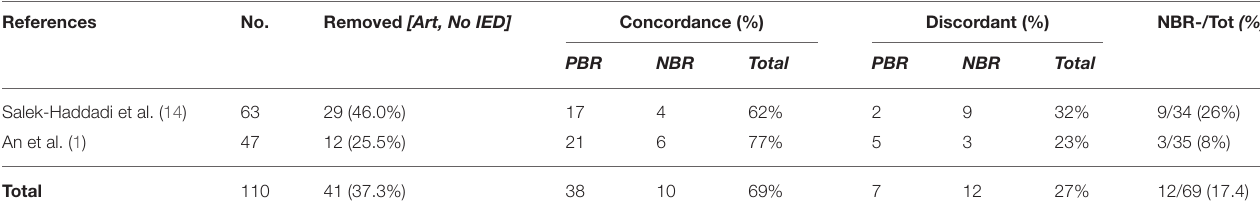
TABLE 2 | Results from two studies (different laboratories) about the accuracy of the EEG-fMRI technique, with specifications to (a) typical percentage of refractory epileptic patients who will not be able to complete a successful EEG-fMRI study and (b) typical percentage of these patients with a “discordant” NBR